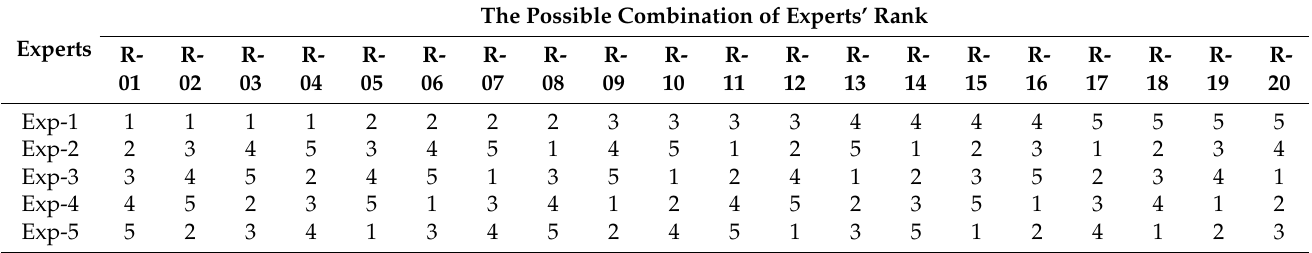
Table 13. Variation in expert’s ranking.